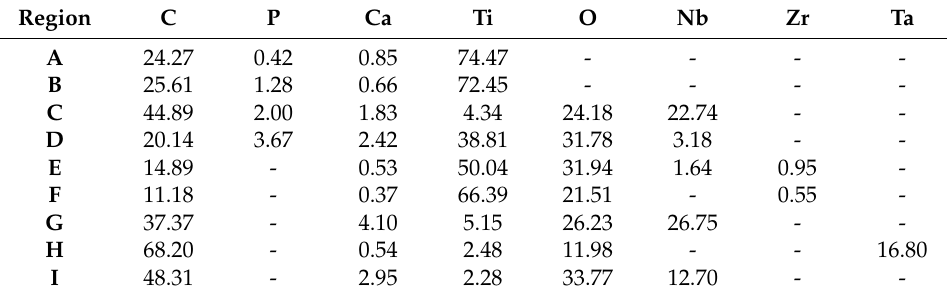
Table 5. The EDS results (at. %) for regions A-I in Figure